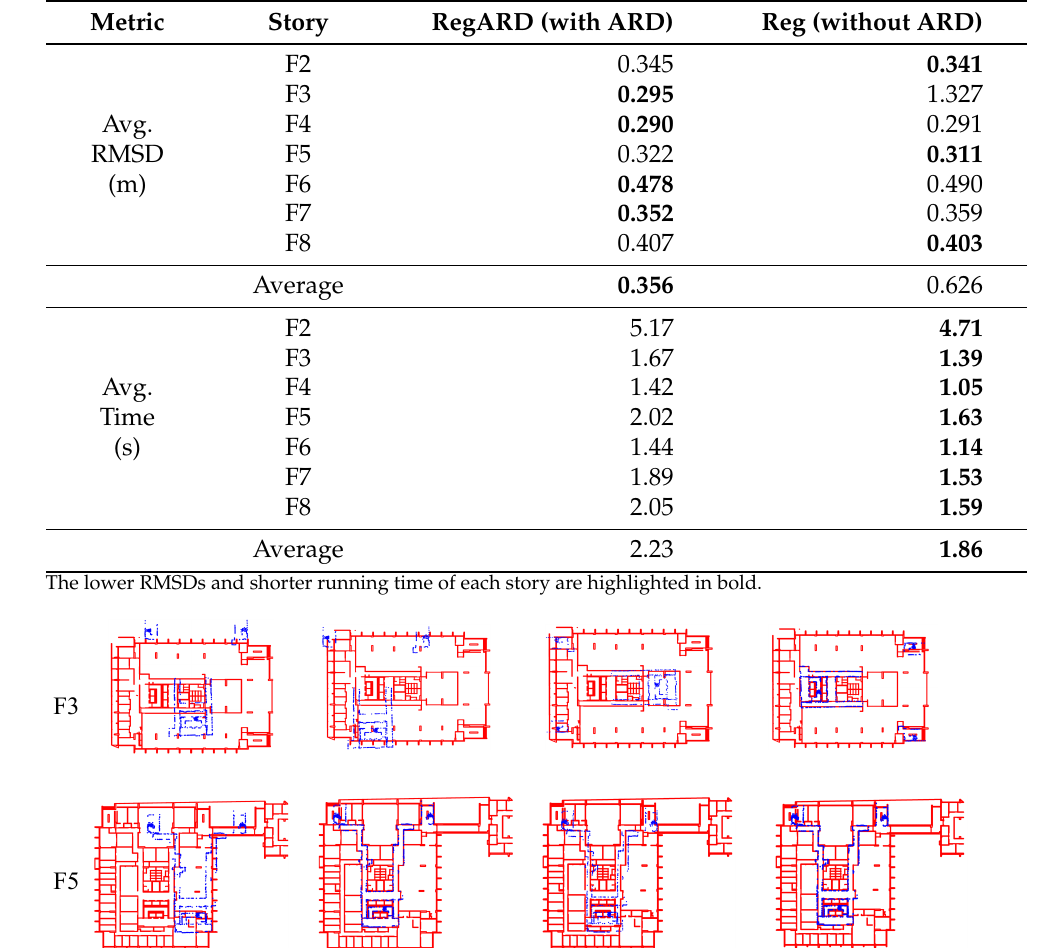
Table 3. Metrics of registration with and without ARD (100 iterations, average of 10 runs).